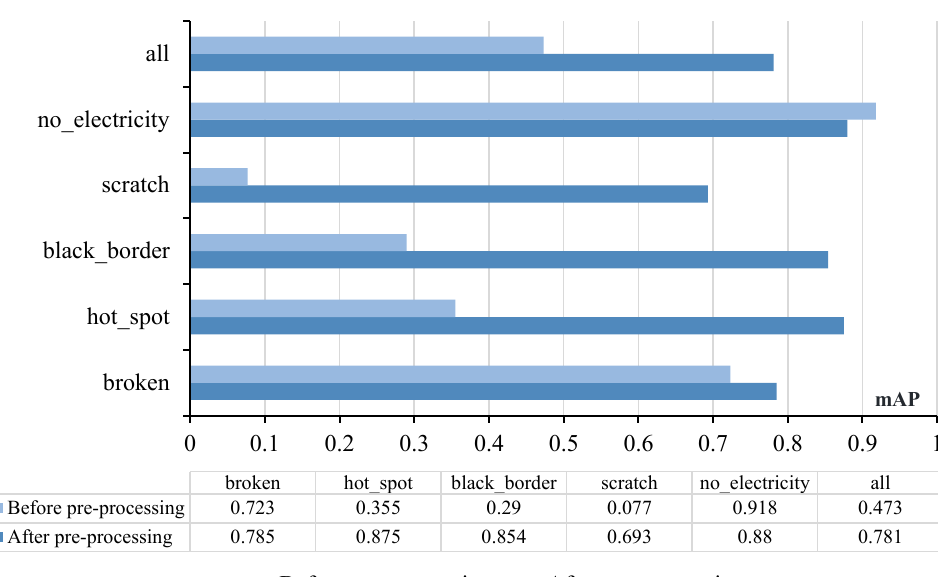
Figure 7. The comparison of each defect’s performance in the PV panel before and after data pre- processing.